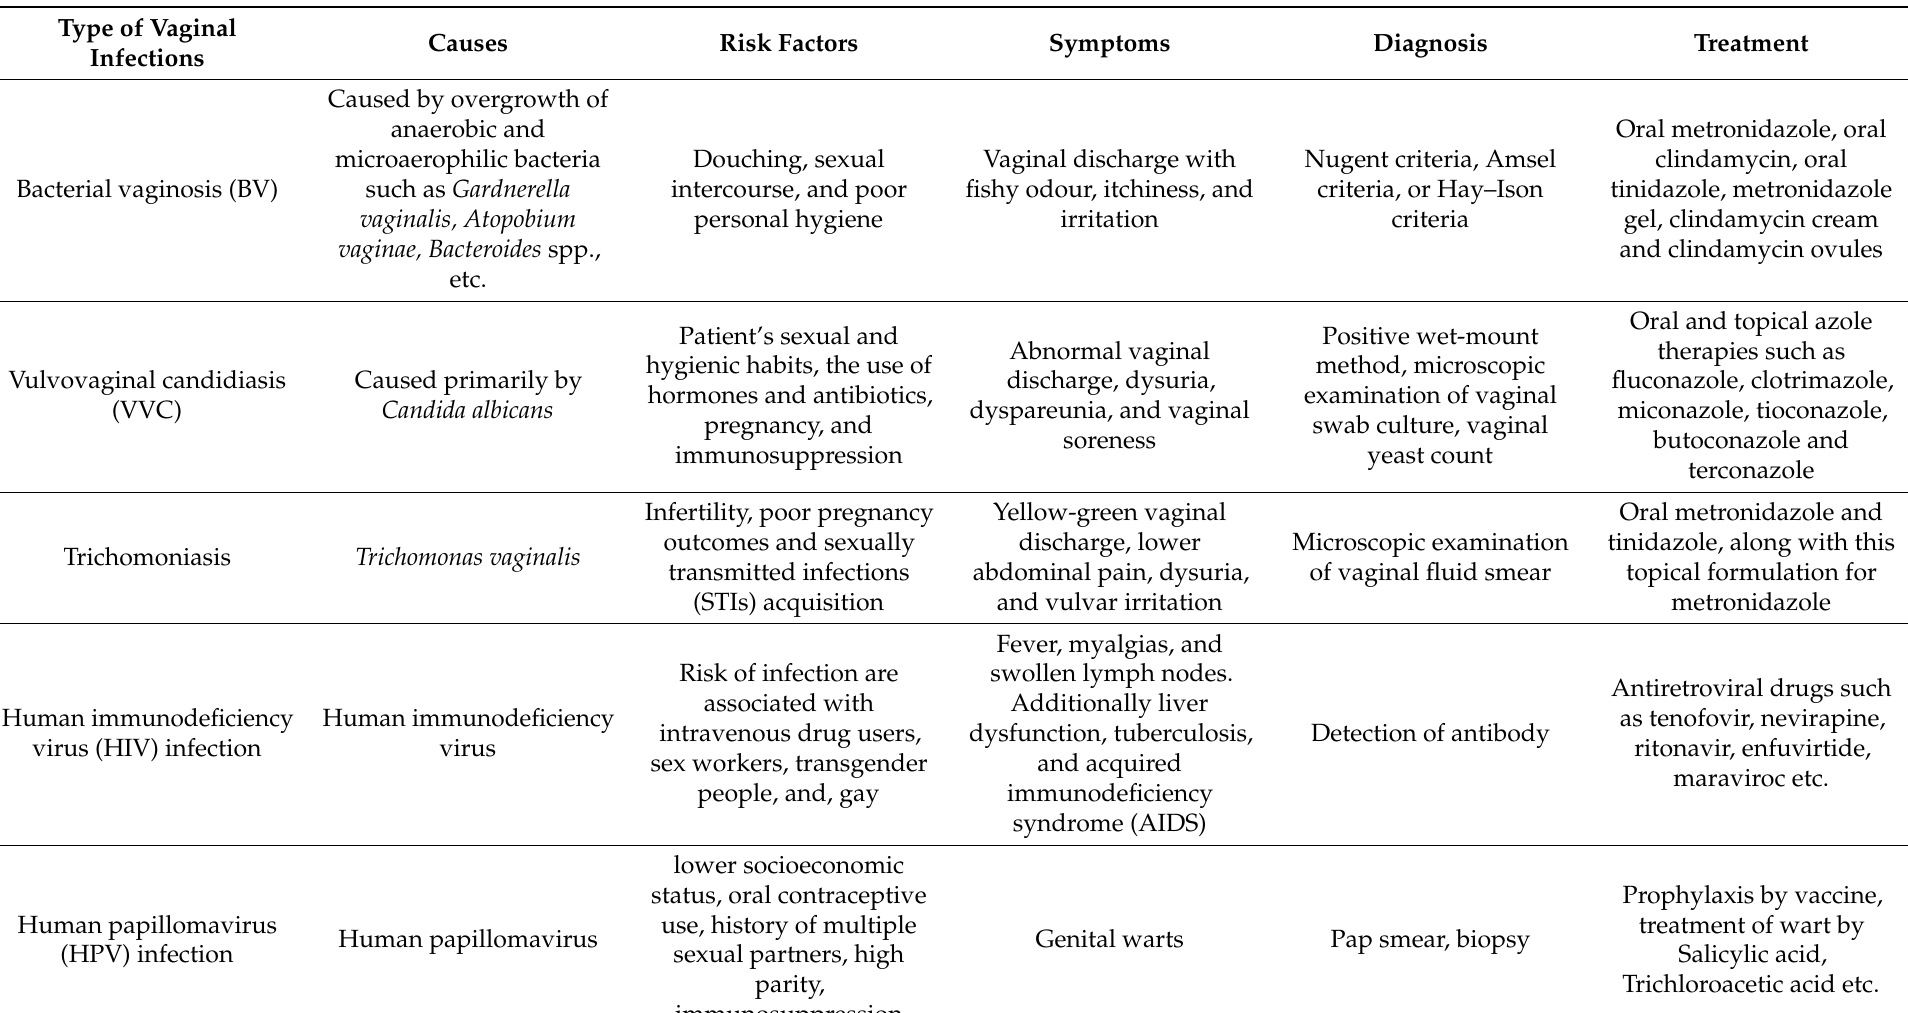
Table 1. Type, symptoms, underlying causes, risk factors, diagnosis and treatment of vaginal